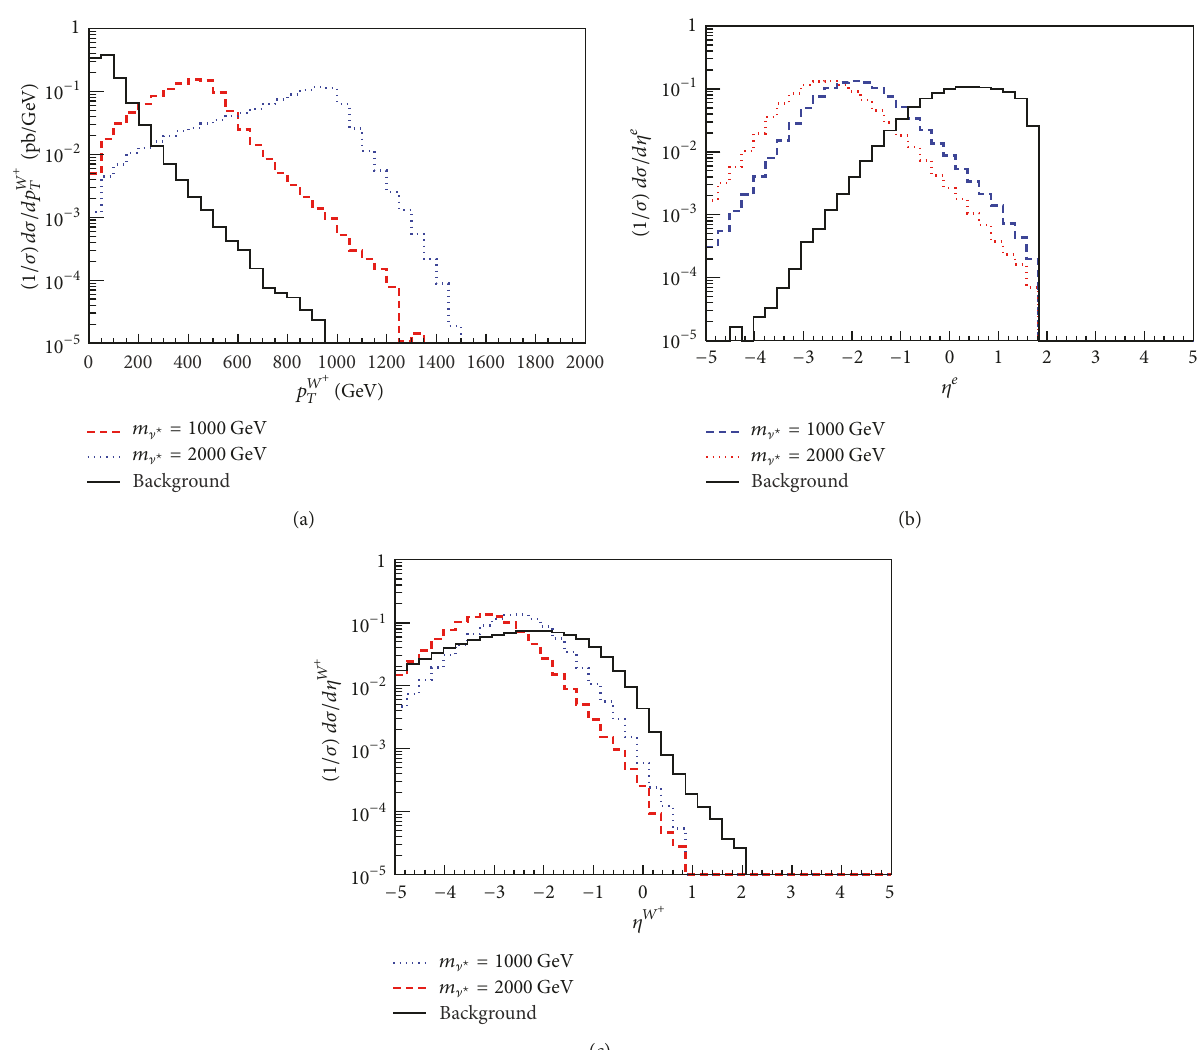
Figure 4: The normalized transverse momentum distributions of the final state 𝑊 + bosons (a), the normalized pseudorapidity distributions of the final state electrons (b), and the normalized pseudorapidity distributions of the final state 𝑊 + bosons (c) for 𝑓 = 𝑓 󸀠 = 1 and Λ = 𝑚 ] ⋆ at the ERL 60 ⊗ FCC collider.